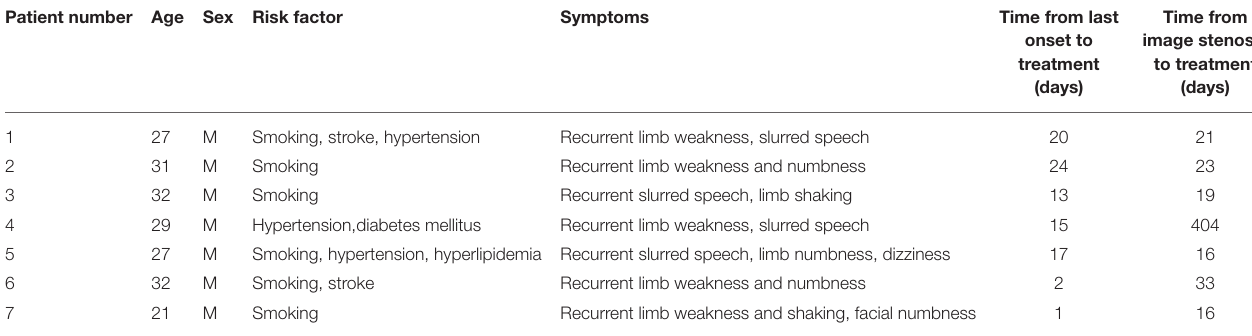
TABLE 1 | Baseline clinical characteristics.